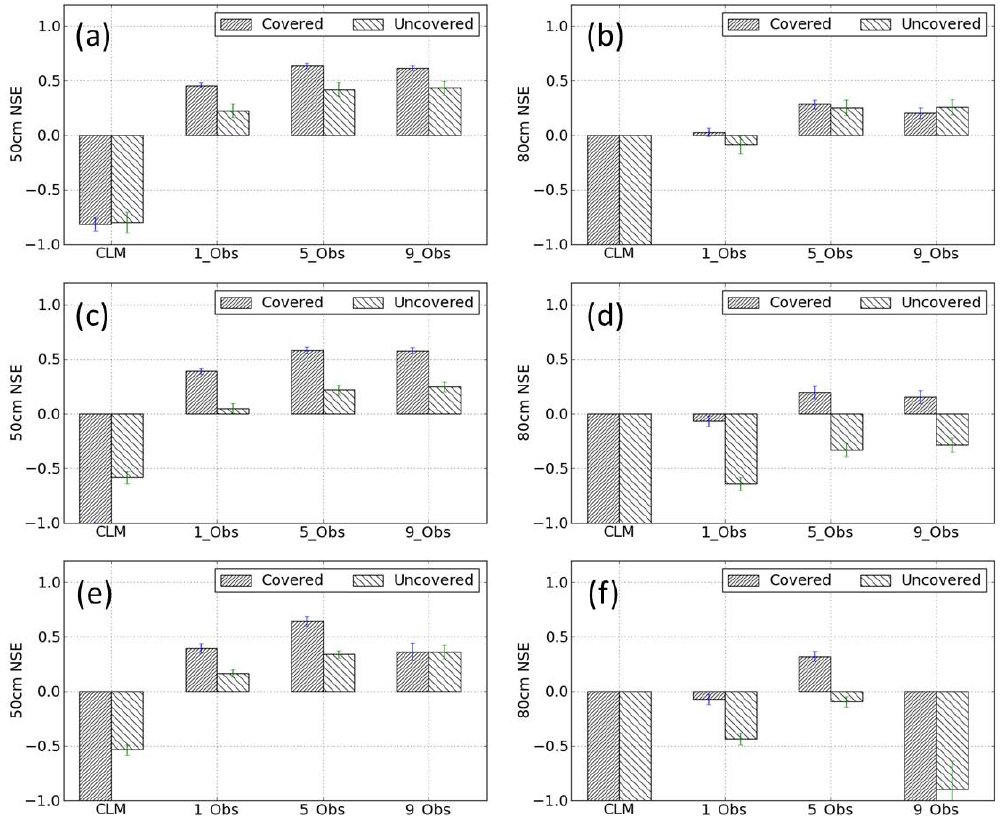
Fig. 6. Mean NSE values of soil moisture (including 95% confidence intervals) for open loop simulations (CLM) and three assimilation strategies of 1 observation used (1 Obs), 5 observations used (5 Obs) and 9 observations used (9 Obs) for 50cm and 80cm depth. Results are shown for 70% – 50cm (a) , 80cm (b) – 47% – 50cm (c) , 80cm (d) – and 31% – 50cm (e) , 80cm (f) – observational